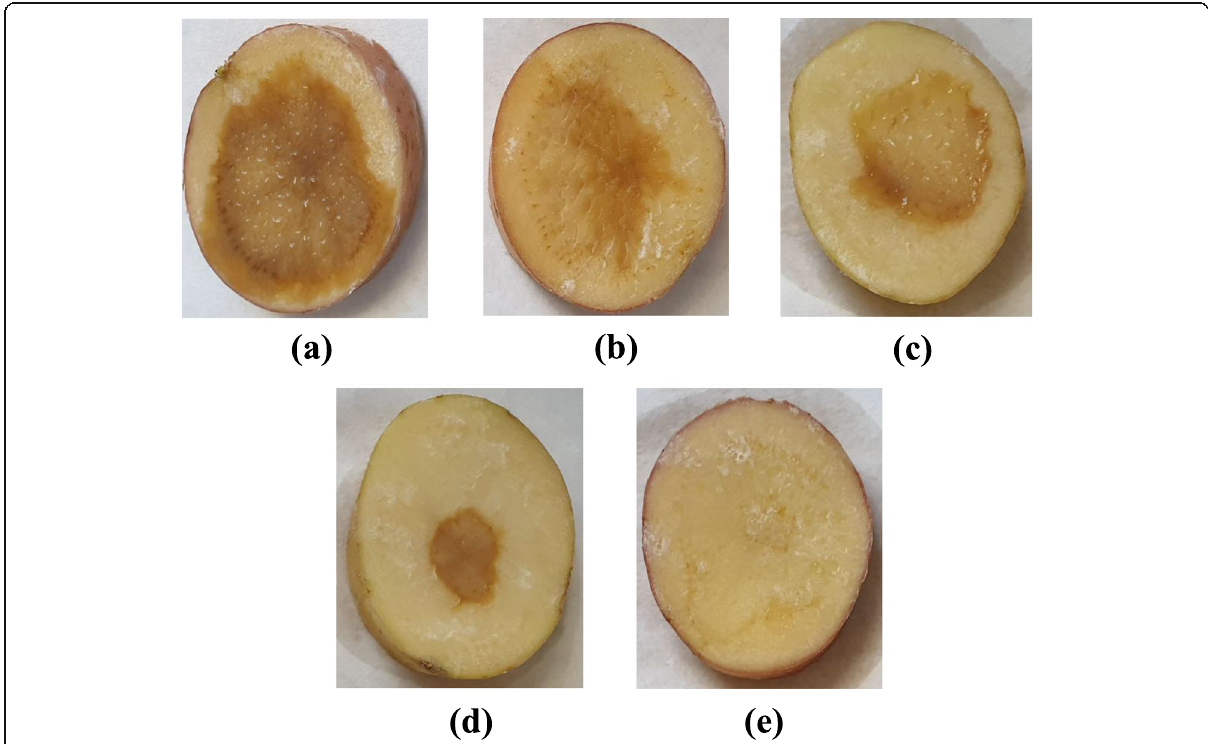
Fig. 1 Effect of different antagonistic bacteria on suppression of soft rot development of potato. a Negative inhibition. b , c , and d are representatives of increased symptom suppression soft rot development. e Total inhibition of soft rot